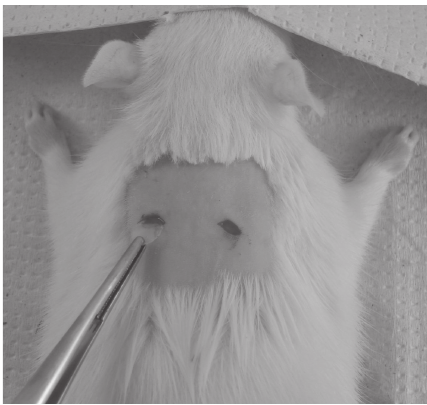
Figure 1: Surgical implantation of PLDLA/PCL-T membrane. A membrane disc was implanted in the incision on the left while the incision on the right served as the control.